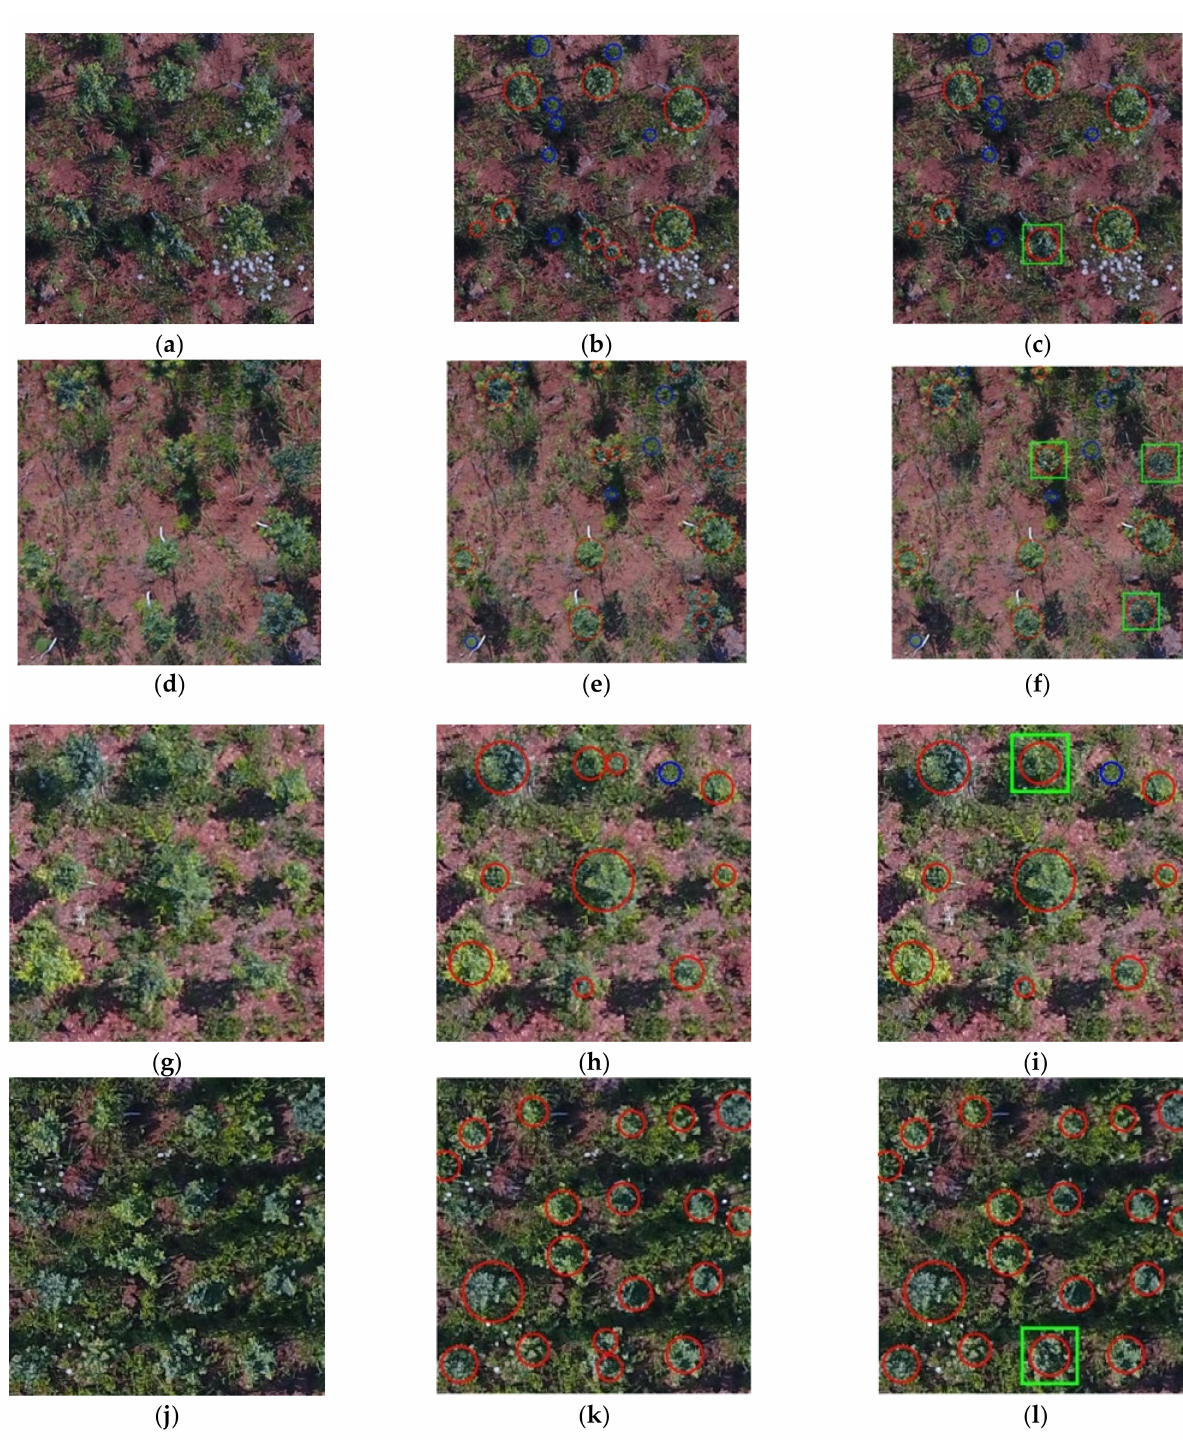
Figure 7. Recognition and fusion results of MREFCM under different conditions. ( a ) Sample image under LFVC and IB; ( b ) recognition results of ( a ) by RF; ( c ) fusion results of ( b ); ( d ) sample image of HFVC and IB; ( e ) recognition results of ( d ); ( f ) fusion result of ( e ); ( g ) sample image of HFVC and SB; ( h ) recognition results of ( g ); ( i ) fusion result of ( h ); ( j ) sample image of HFVC and IB; ( k ) recognition results of ( j ); ( l ) fusion result of ( k ). As shown in Figure 7c,f,i,l, the green rectangle marked the fused crown, correspond- ing to the fragments in the extraction region caused by illumination or crown shape in Figure 7b,e,h,k. The Equation (11) introduced in Section 2.6 was used to calculate the distance threshold L , the judgment of the threshold between RoIs depended on the